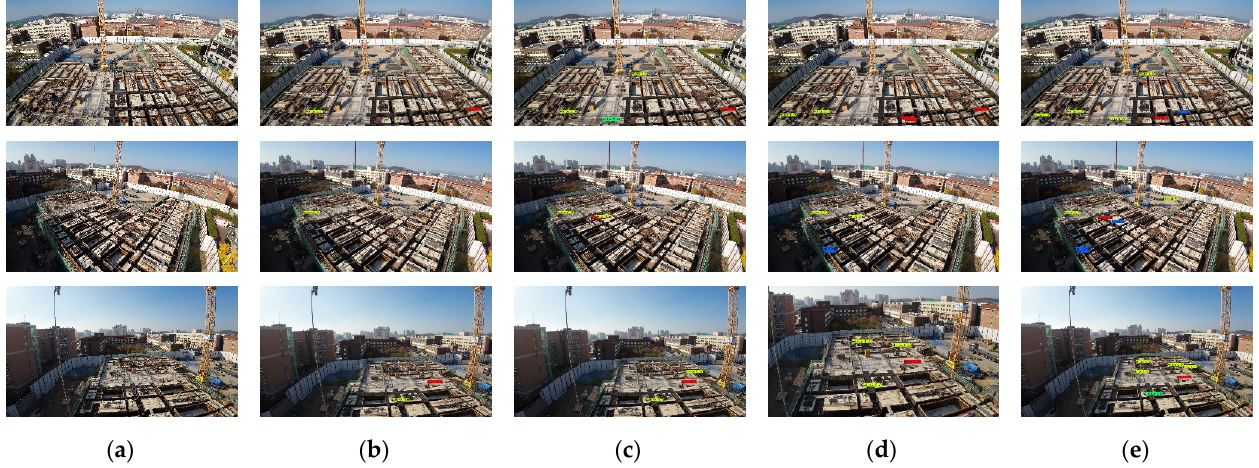
Figure 17. Comparison of each model based on images collected using a UAV with a flight altitude of 15 m. ( a ) Original image ( b ) SSD, ( c ) Faster R-CNN, ( d ) YOLOX, and ( e ) Our Approach.